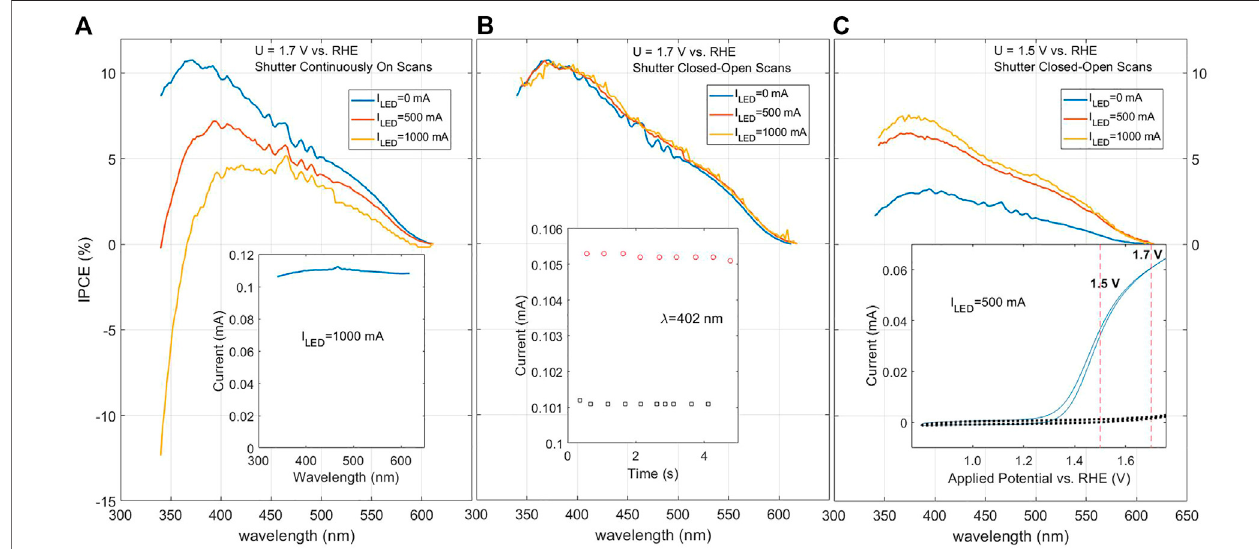
FIGURE 4 | IPCE scans on a30 nm Ti-doped hematite fi lm deposited on a platinized sapphire substrate, for different light bias intensities (1000 mA LED current is comparable to 1 sun). (A) Measured by the base system and method, before the shutter on-off method was implemented. In this case, the current is measured as the monochromatorisincrementedfromhightolowwavelengths.Theinsetshowsthetotalmeasuredcurrent(includingfromthelightbias)ofsuchascanunderstronglight bias.Theappliedpotentialwassetto1.7 VRHE,neartheplateauregionasindicatedintheinsetof (C) . (B) Usingtheshutterclosed-openscheme.Theinsetshows thecurrentvs.timemeasurementsforoneofthewavelengthpoints,withshutteropen inred (upper) ,shutter closedinblack (lower) . (C) Usingtheshutteropen-closed scheme, but for the applied potential lowered to 1.5 V, which is below the plateau region of the J ph -U curve, shown in the inset; dark current is shown as the black dashed